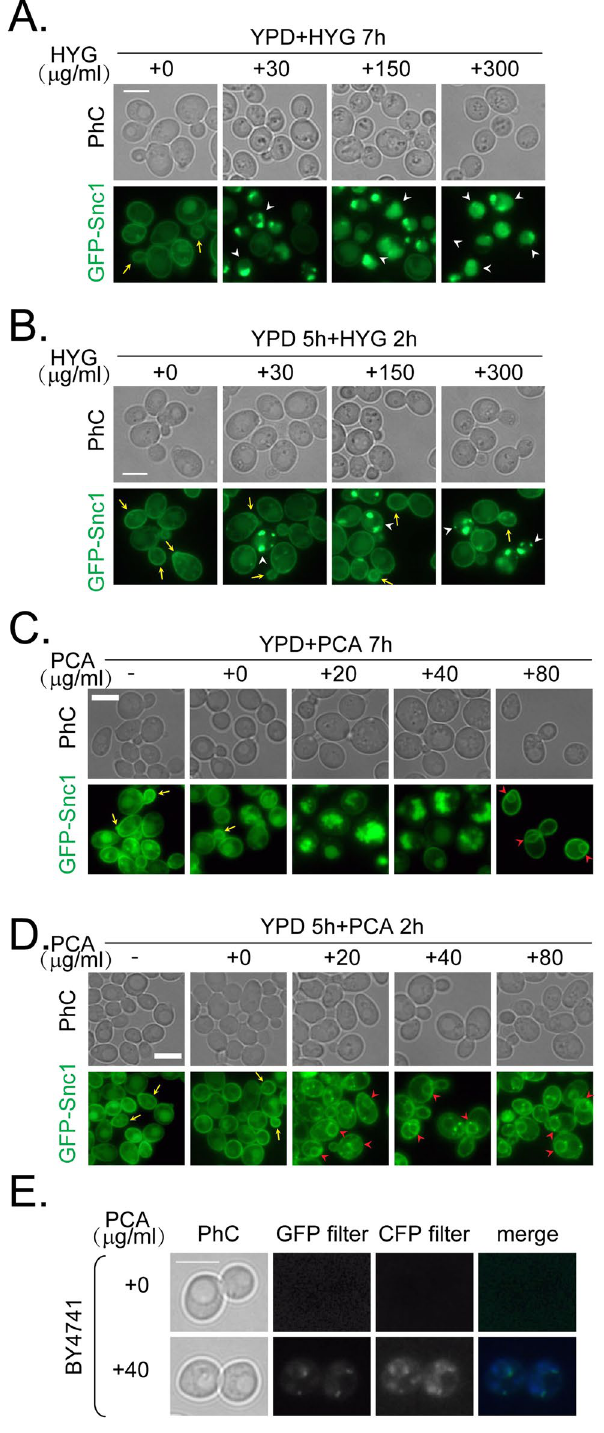
Figure 5. Treatment with PCA disrupts the trafficking of Snc1 differently than hygromycin B. ( A ) Wild-type cells tagged with GFP-Snc1 were grown in YPD to an initial OD 600 = 0.1 with the indicated concentrations of HYG for 7 h. ( B ) Wild-type cells tagged with GFP-Snc1 were grown in YPD to mid-log phase for 5 h and treated with the indicated concentrations of HYG in YPD for 2 h. Arrows indicate cells with polarized Snc1 at the bud or bud tip. White arrowheads indicate intracellular GFP-Snc1 puncta ( A and B ). ( C and D ) Cells were grown and treated as in panels A and B, except that PCA was used at the indicated concentrations. Red arrowheads indicate the ER ring inside the cell ( C and D ). ( E ) Wild-type cells without fluorescently tagged protein were grown to mid-log phase in YPD and treated with or without 40 μ g/ml PCA in YPD for 2 h. Cells were observed under a microscope with a phase-contrast set and GFP or CFP filters. The bar represents 5 μ m. Results shown in this figure represent two independent